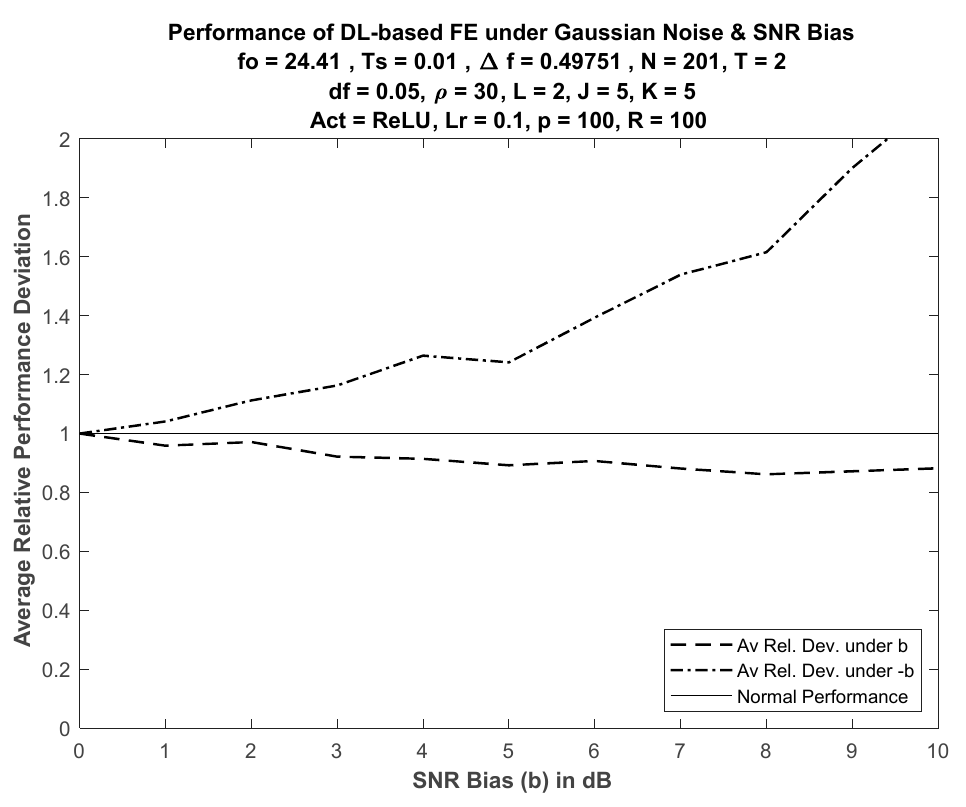
Figure 6. Average performance deviation of DL-based FE versus SNR bias.